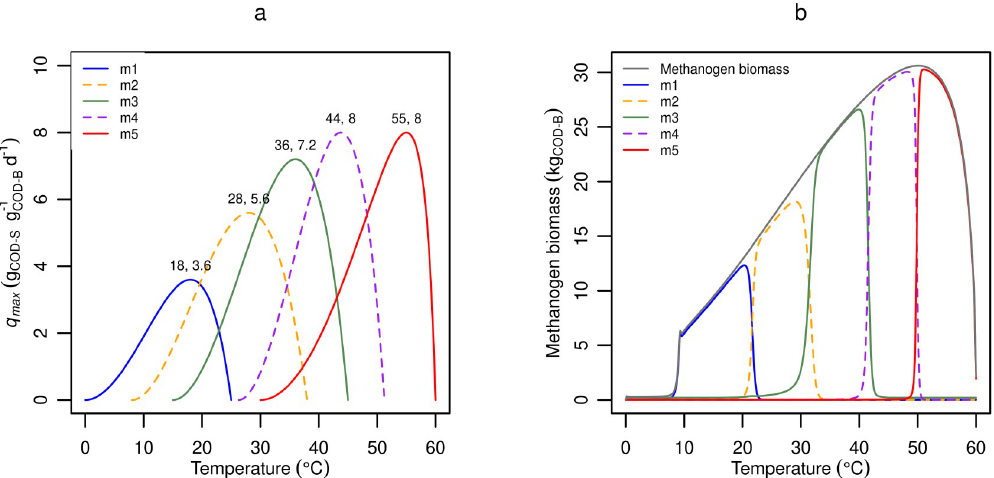
Fig 4. Default temperature responses. (a) Temperature dependence of maximum substrate utilization rates ( q max ) of default methanogen groups in the model (m1 to m5). (b) Steady-state microbial biomass as a function of temperature for default parameter values. The residual fraction of slurry ( f resid ) was set to 0.95 in this simulation.